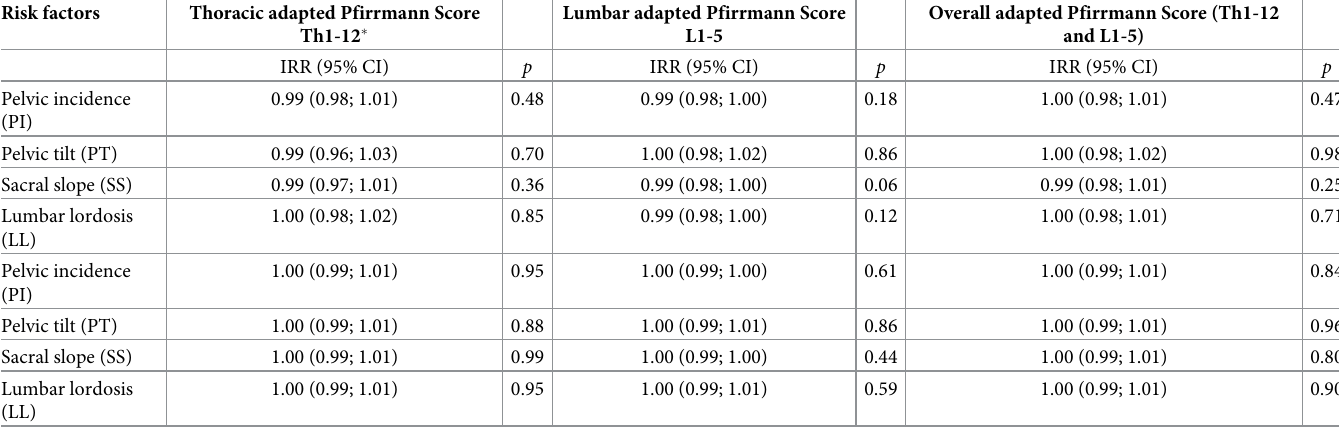
Table 4. a. Multivariable correlation of spinopelvic parameters with number of affected segments (discs). b. Multivariable correlation of spinopelvic parameters with mean overall Pfirrmann Score. Risk